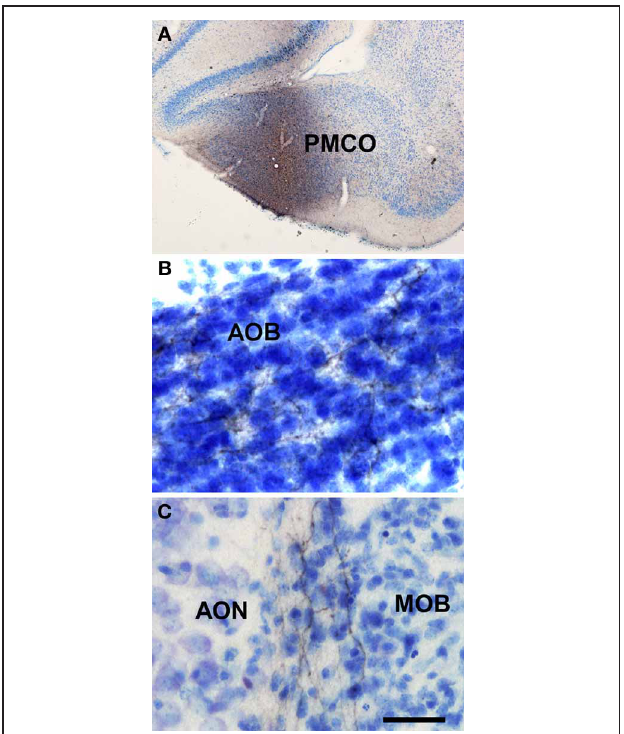
FIGURE 6 | Coronal (A) and sagittal (B,C) sections of the telencephalic hemisphere showing the resulting labeling (B,C) after a biotinylated dextran-amine injection in the rat posteromedial cortical amygdala (A). Abbreviations: AOB, accessory olfactory bulb; AON, anterior olfactory nucleus; MOB, main olfactory bulb; PMCO, posteromedial cortical amygdala. Scale bar for A : 800 μ m, B,C : 40 μ m.